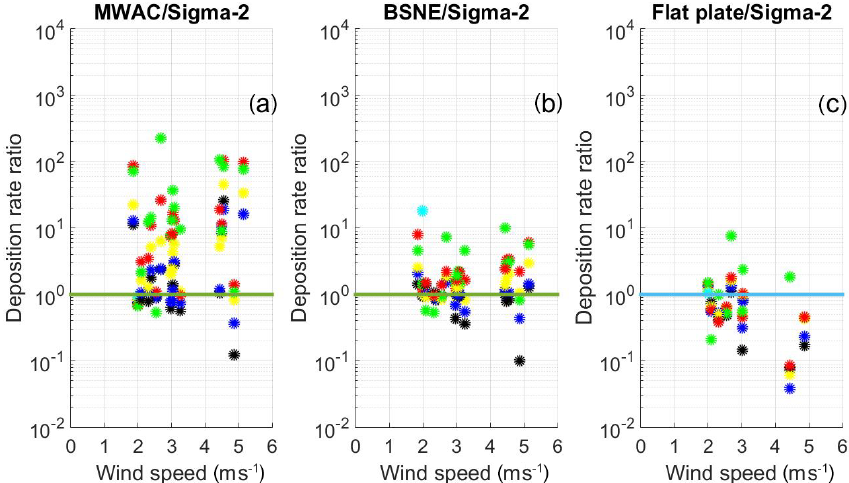
Figure 7. Deposition rate ratio as function of wind speed for different days: MWAC/Sigma-2 (a) , BSNE/Sigma-2 (b) and BSNE/Sigma-2 (c) . Different colors represent deposition rates measured in different size intervals (black: 1–2µm; blue: 2–4µm; yellow: 4–8µm; red: 8–16µm; green: 16–32µm; cyan: 32–64µm).